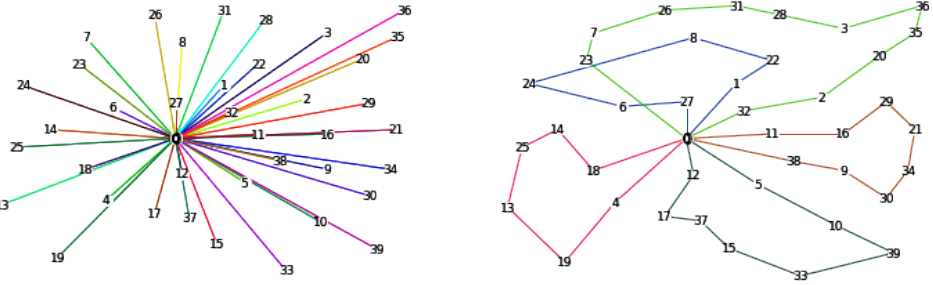
Figure 2. Comparison between starting and final solutions of the CWS